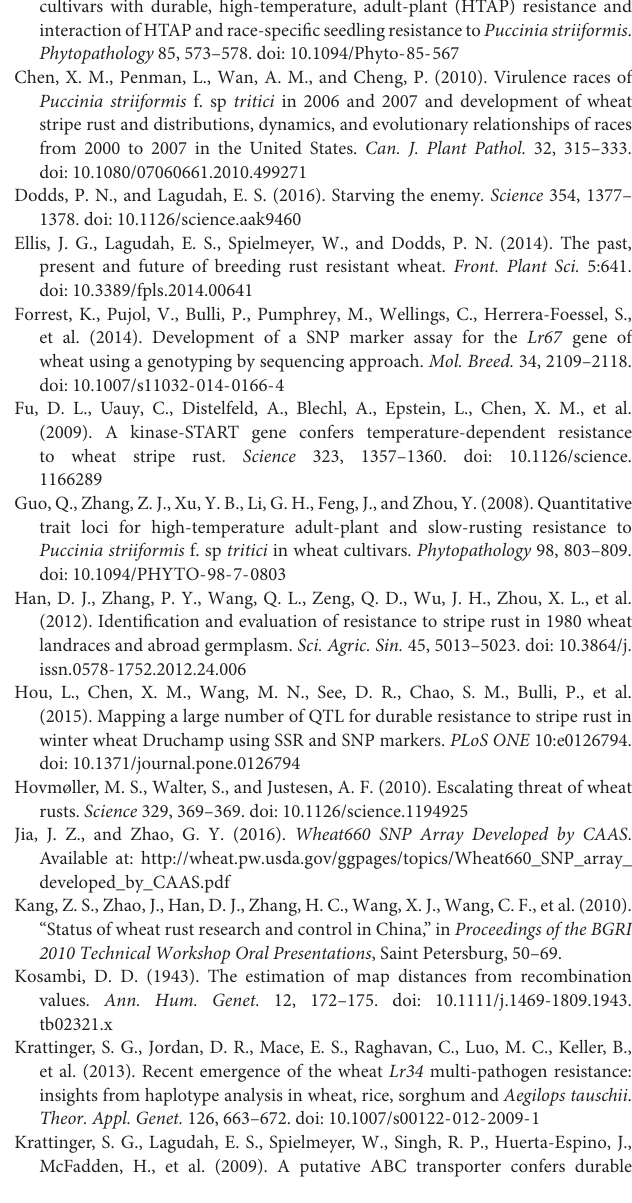
FIGURE S1 | Pedigrees of Napo 63 and Kenya